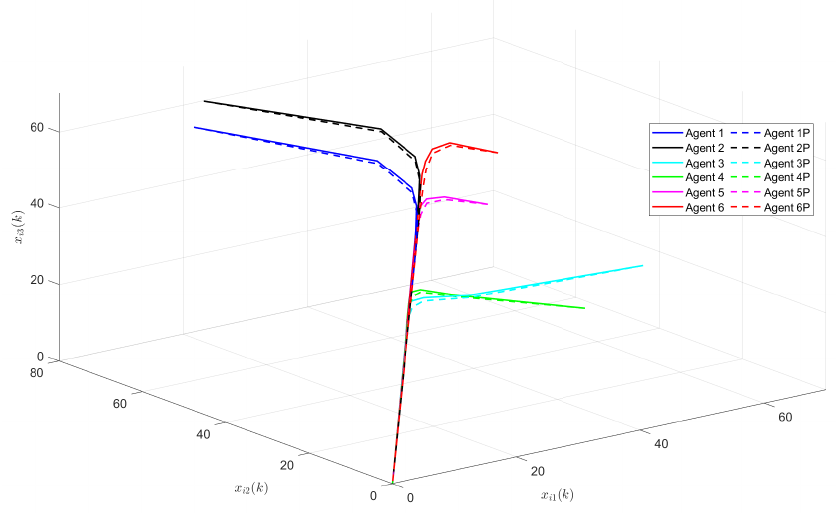
Figure 10. The simulations of states of all the agents.